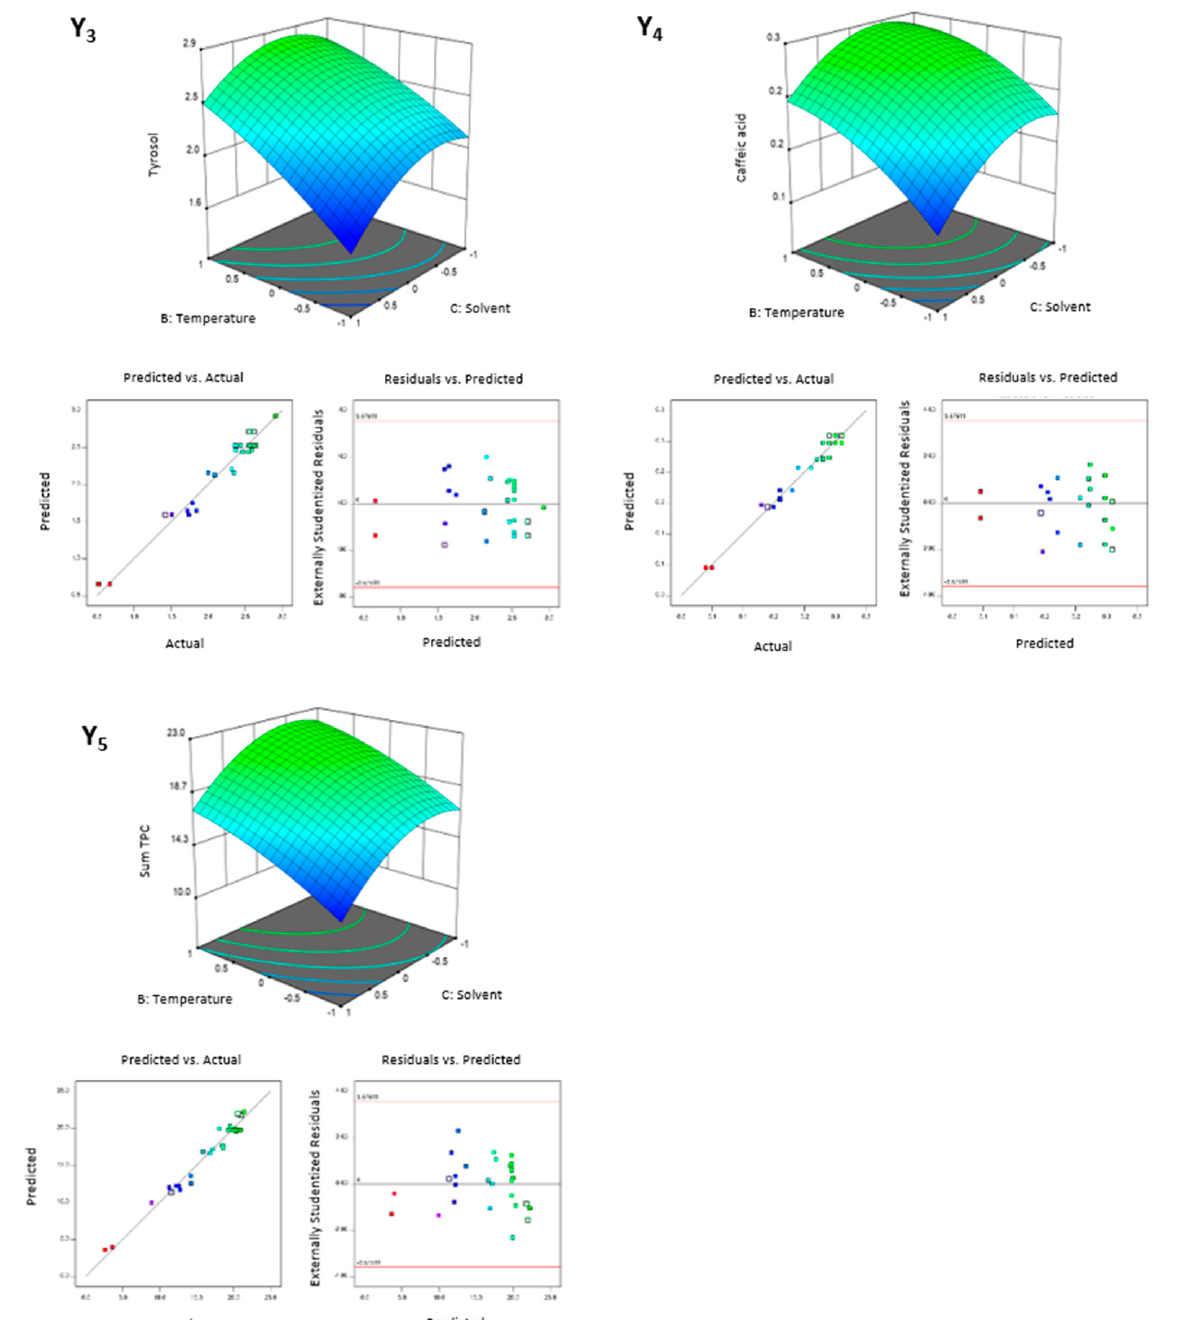
Figure 2. RSM graphs from the responses Y 3 (Tyrosol, mg/g DW), Y 4 (Caffeic acid, mg/g DW) and Y 5 (Total phenolic content, mg/g DW), with statistical diagnostic representations. Each graph displays temperature vs solvent factors, with a time factor adjusted to 0, along with two statistical diagnostics attached. On the left, the graphical representation of the adjustment between predicted vs actual points, and on the right, the graphical representation of residuals vs predicted points.